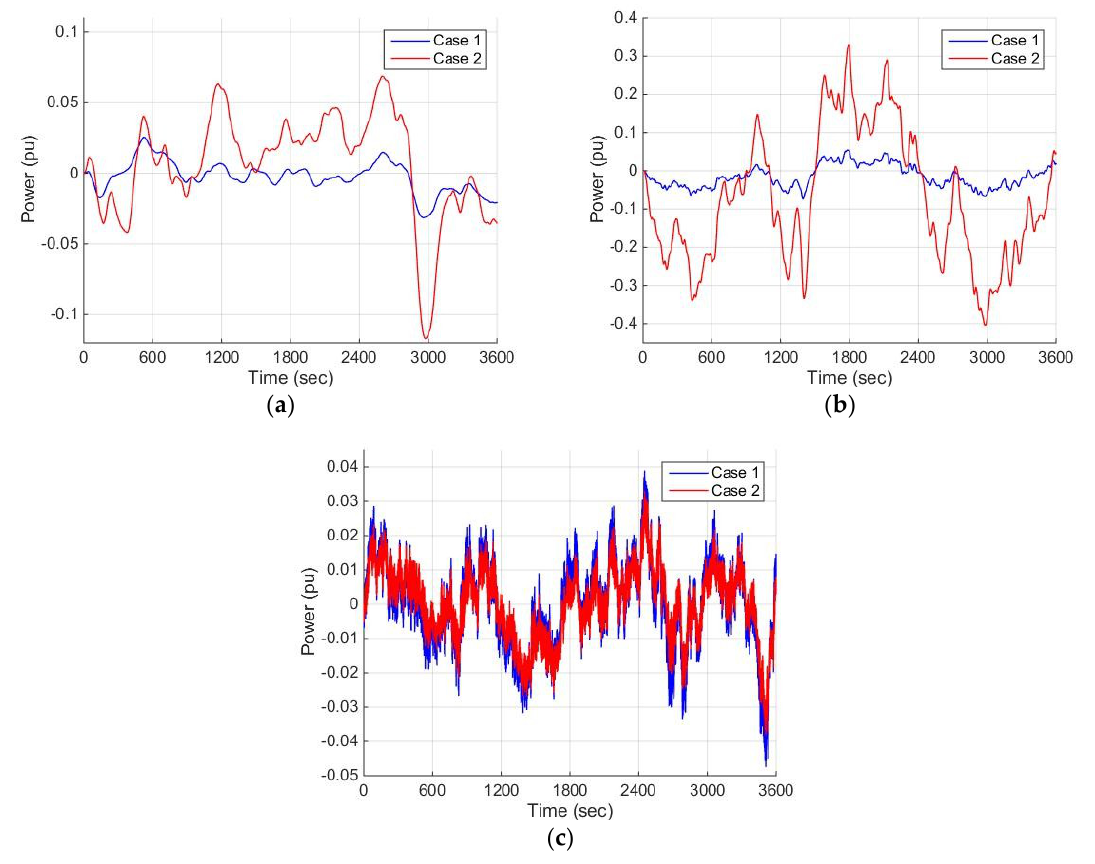
Figure 16. Power transmission under Case 1 and Case 2: ( a ) between MG 1 and MG 2 ; ( b ) between MG 2 and MG 3 ; ( c ) between PG and MG 1